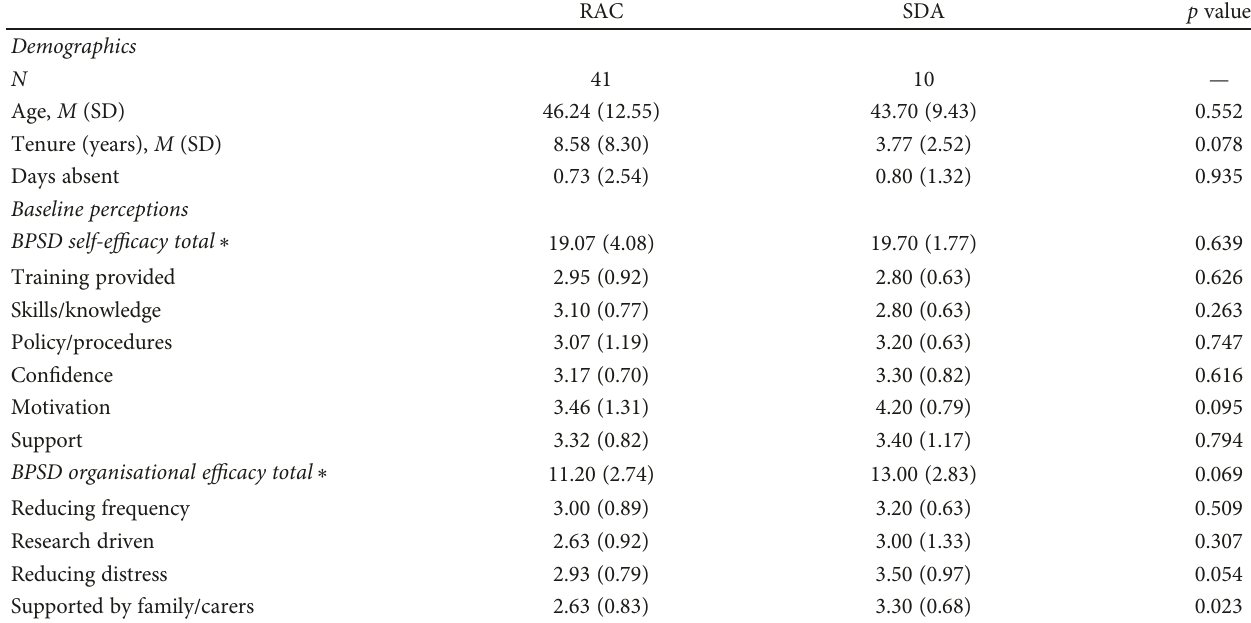
Table 2: Demographic and psychological characteristics of participating sta ff .